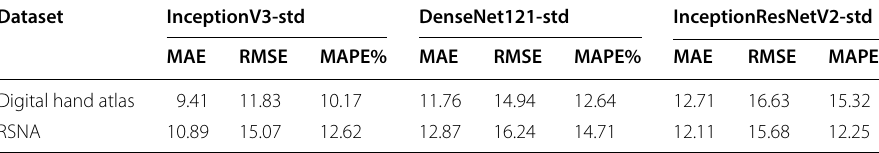
Table 1 Result of standard deep learning models evaluation Dataset InceptionV3-std